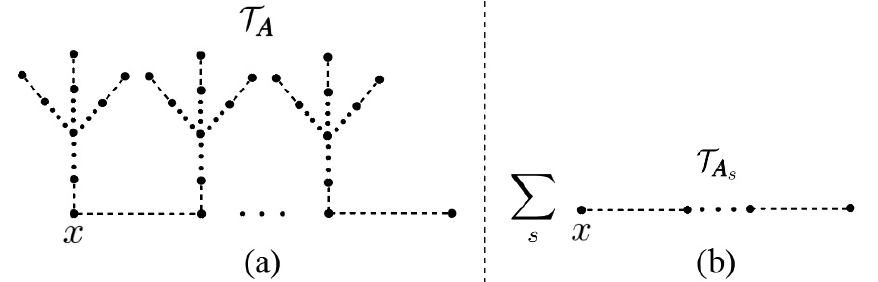
Figure 6 . An arbitrary graph T AAA , as shown by (a), can be decomposed into a sum of simple chains (shown by (b)) where node x plays as an end node of each simple chain T T AAA s